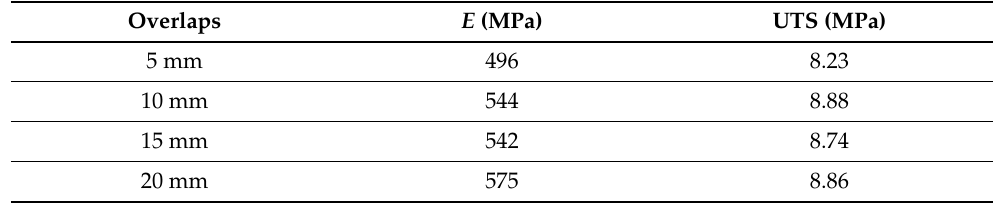
Figure 17. Fractured samples of interlaced infills with different overlaps: 5 mm, 15 mm, and 20 mm. Table 4. Tensile test data for different sizes of